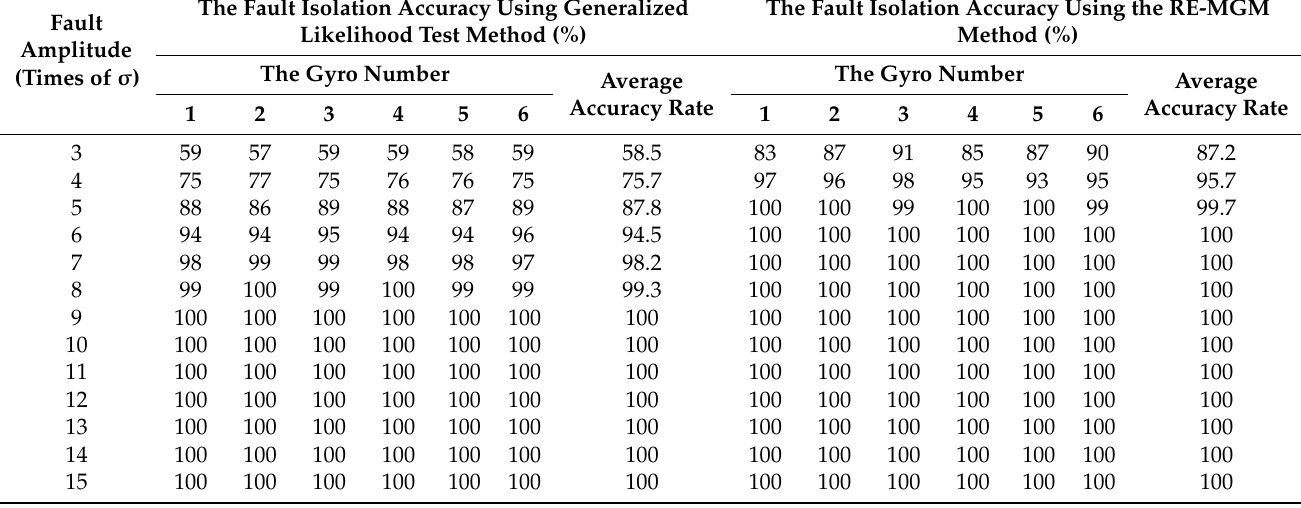
Table 1. Comparison of fault isolation accuracy rate between two methods. The Fault Isolation Accuracy Using Generalized Fault Likelihood Test Method Amplitude (Times of σ )